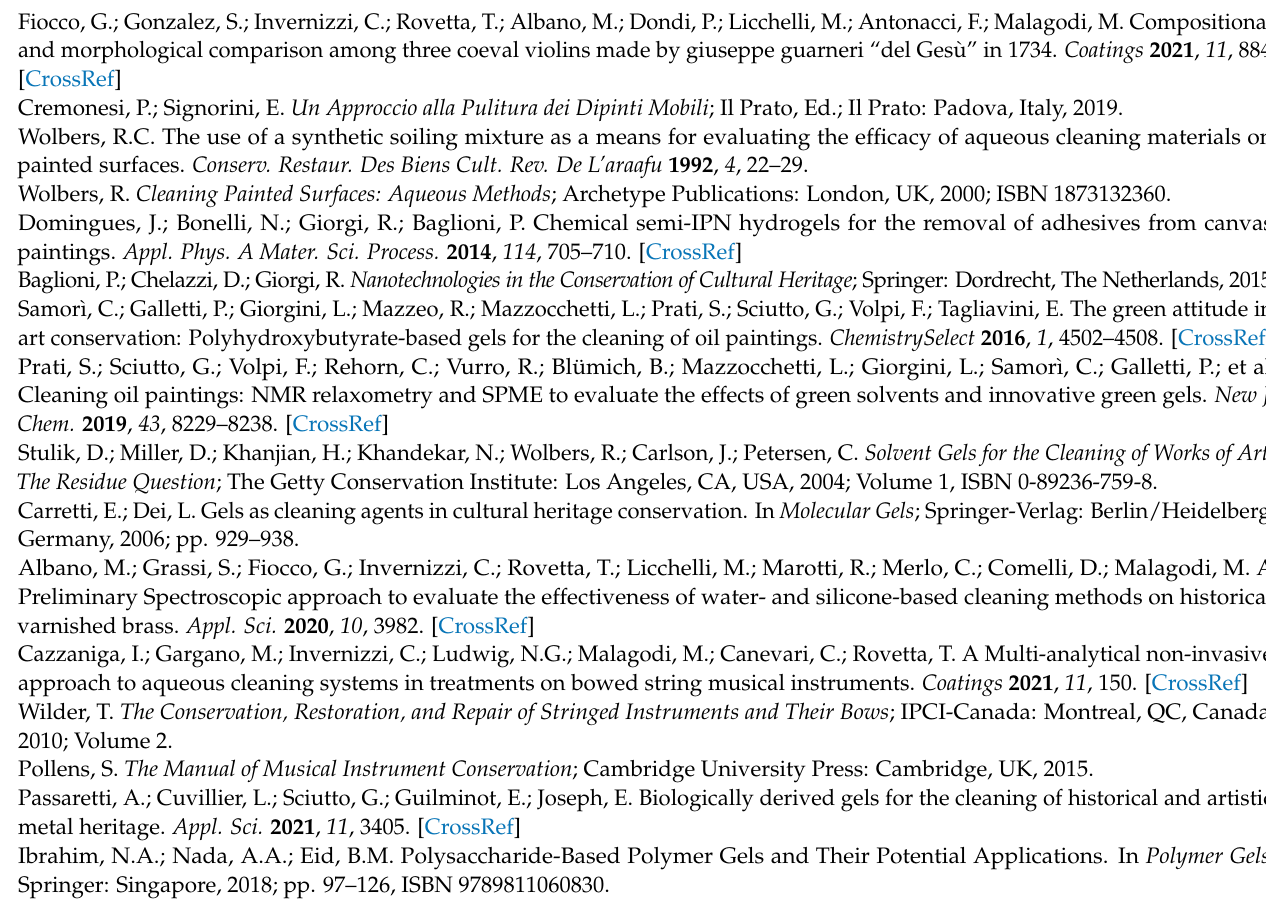
Figure S1: Images related to gelation of SA; Table S2: Reflection FTIR band